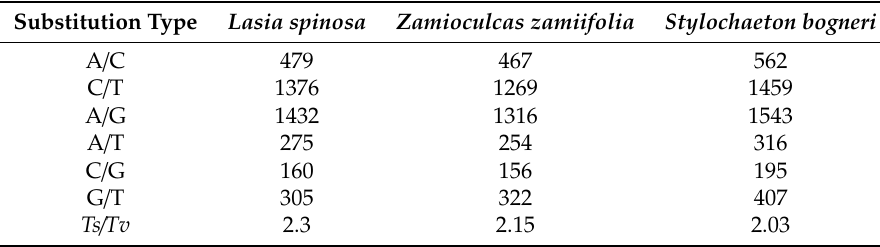
Table 3. Transition and transversion substitutions in protein-coding